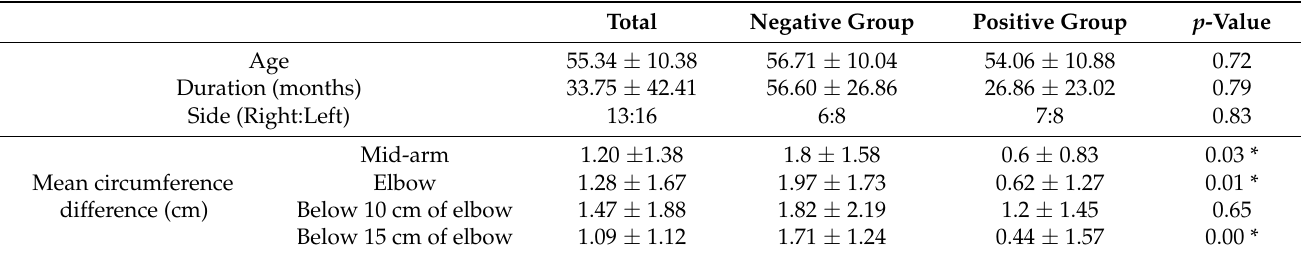
Table 1. Demographic data.